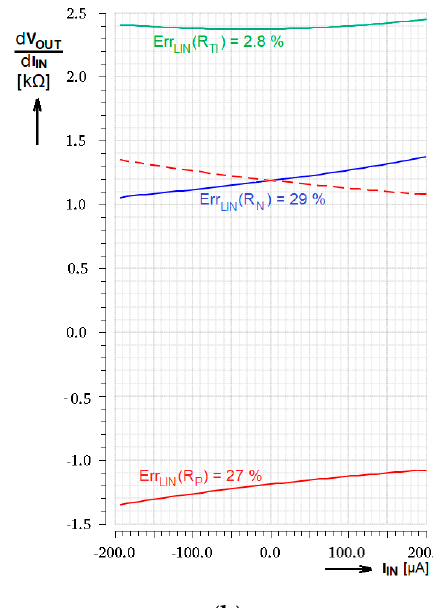
I IN ; ( b ) Transimpedance gain as the derivation of the transimpedance transfer functions.